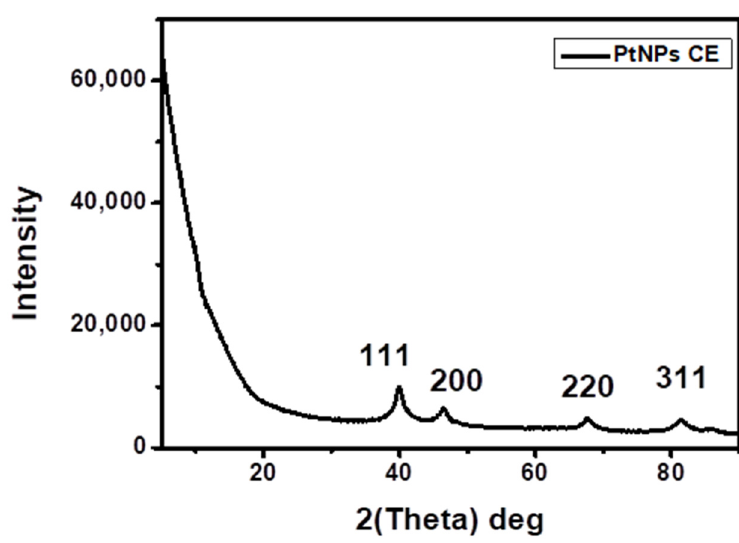
Figure 2. XRD patterns of the as-synthesized PtNPs CE.